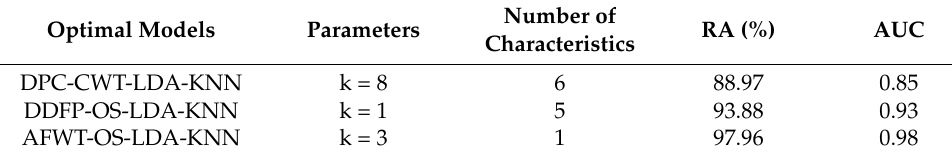
Table 6. Optimal model performance parameters.